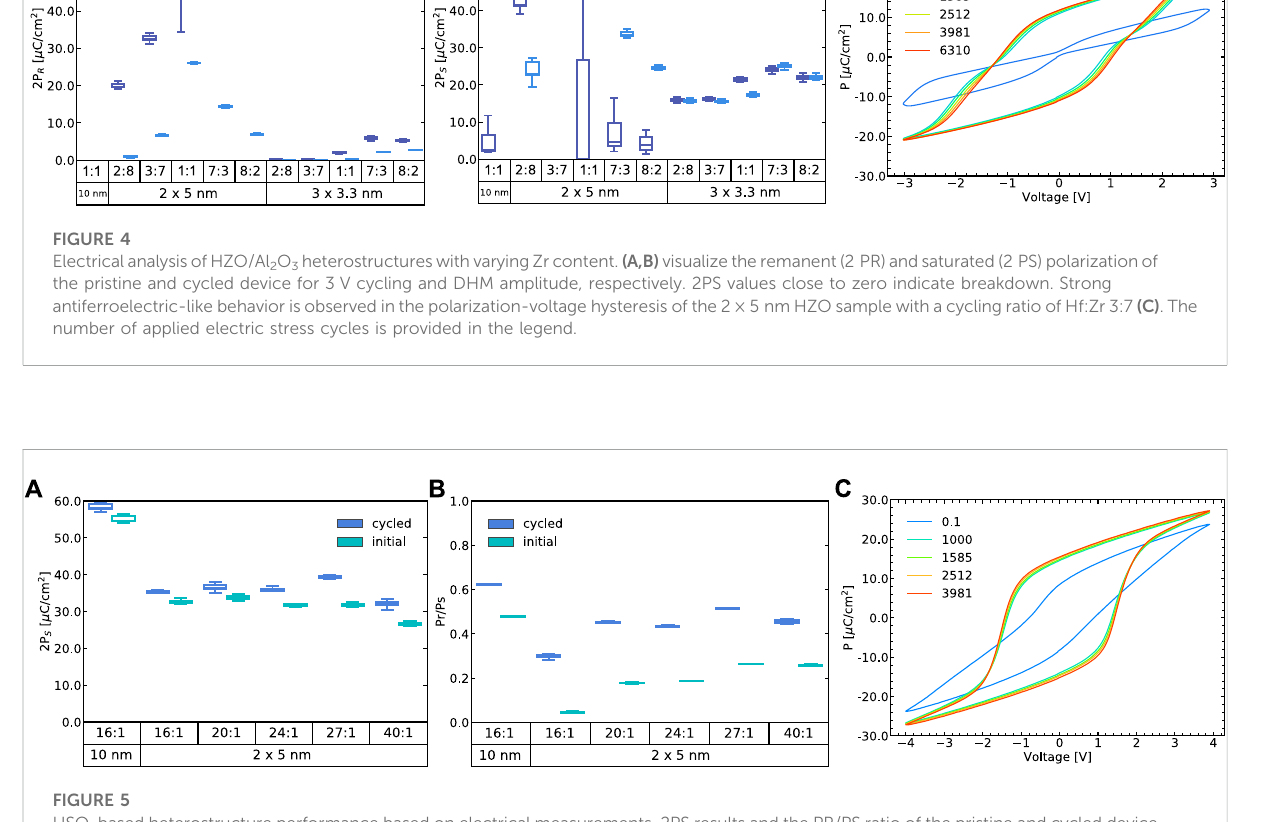
HSO-based heterostructure performance based on electrical measurements. 2PS results and the PR/PS ratio of the pristine and cycled device aregivenin (A,B) ,respectively,forancyclingandDHMamplitudeof3 V.Nostrongimpacton2 PSisobservedindependenceonthecyclingratio. (C) Visualized the polarization-voltage hysteresis over electric fi eld cycling for the 2 × 5 nm HSO sample with a cycling ratio of 27:1. Here an increased cycling and DHM amplitude of 4 V is used. The number of applied electric cycles is provided in the